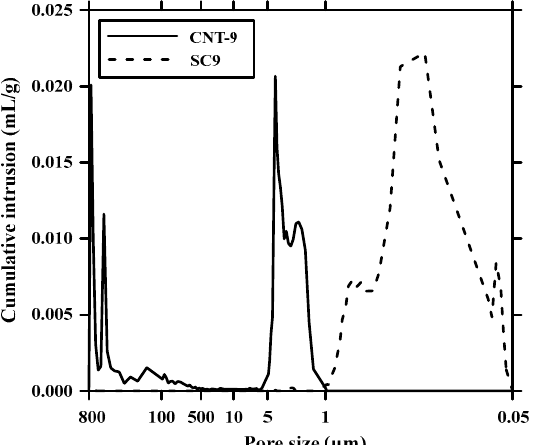
Figure 9. Change in dry shrinkage of composites according to S-CNT.